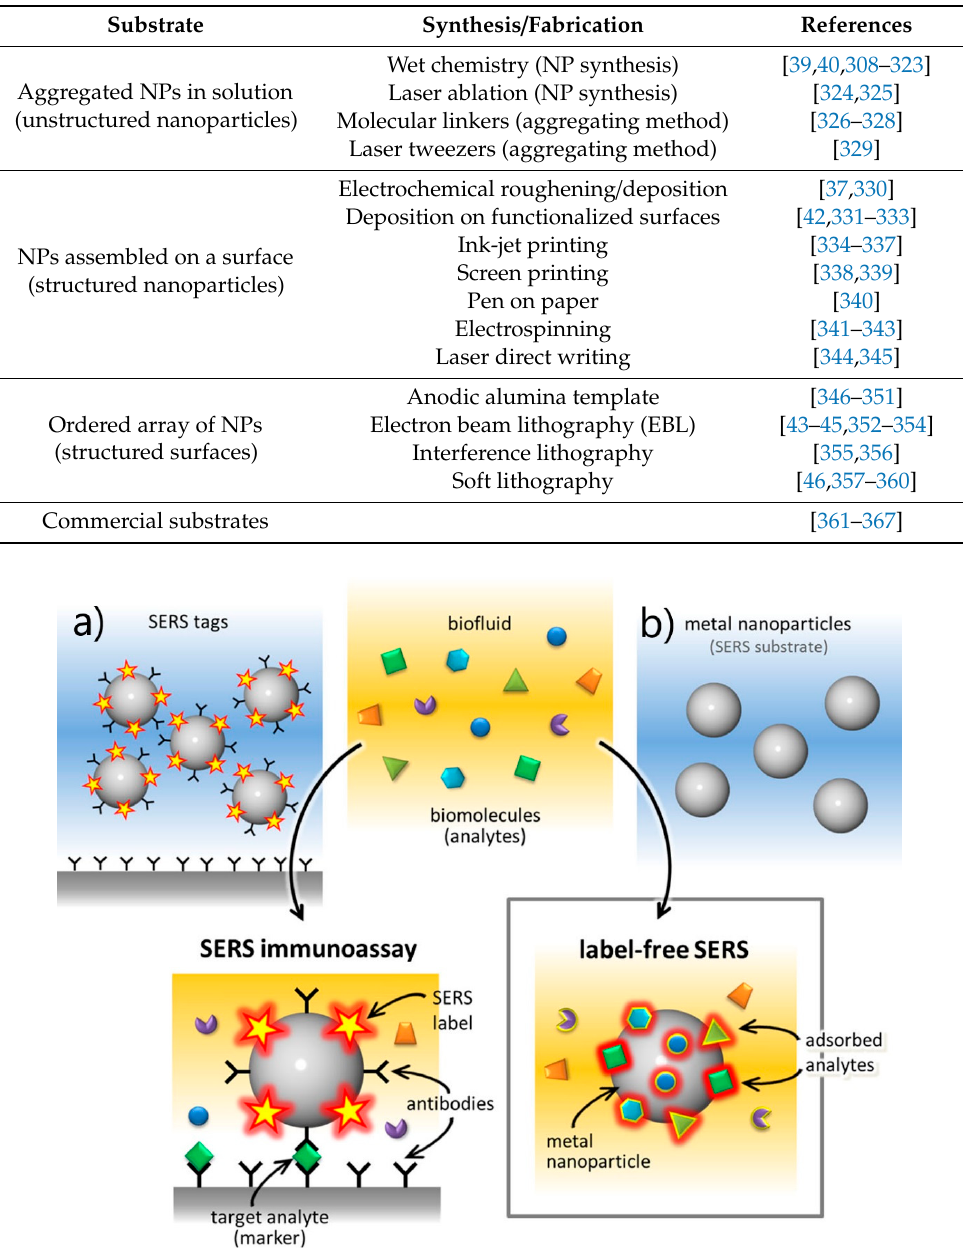
Figure 22. ( a ) Indirect protocol. A SERS tag is functionalized with antibodies and selectively binds to the analyte; its detection is carried out through the spectrum of the Raman reporter contained in the SERS tag. ( b ) Direct protocol. The analyte is adsorbed on the nanoparticle and detected through its own Raman spectrum. Reproduced with permission from Bonifacio et al. [304]. Copyright (2015), Springer-Verlag Berlin Heidelberg.